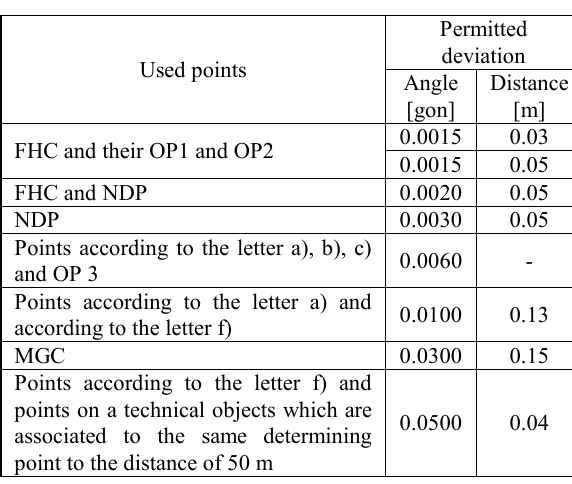
Table 2. Permitted deviations for measurement between horizontal